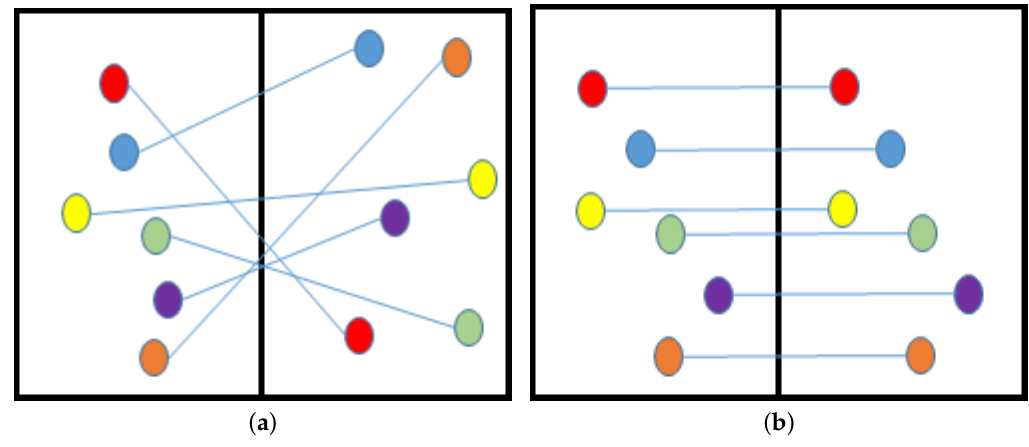
Figure 6. Feature Matching between two halves could determine the types of 3D images. ( a ) Matches are not horizontally aligned on “normal " image; ( b ) Matches are horizontally aligned on side by side